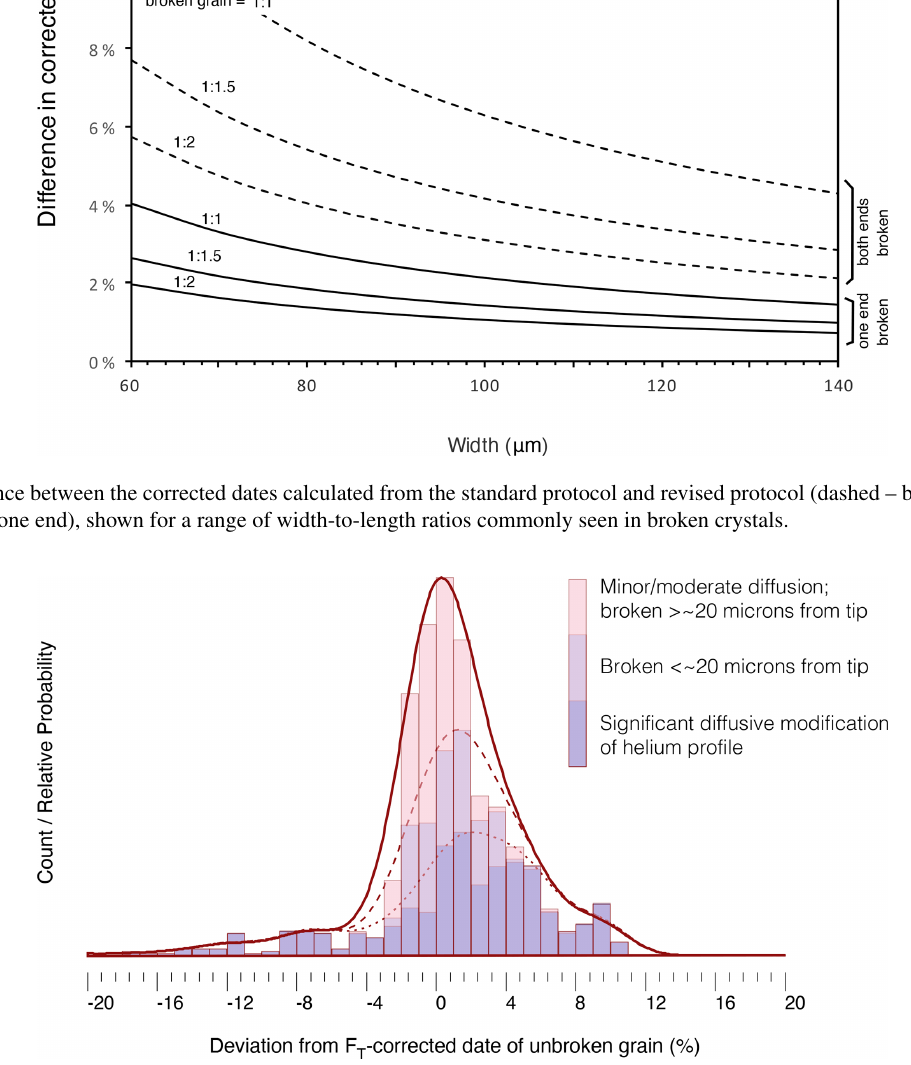
Figure 5. Uncertainty associated with the proposed fragmentation correction due to inclusion of fragments broken too close to the tip (dashed) and due to thermal histories that involve significant diffusive modification of the helium profile (dotted). The histogram and curves are stacked and cumulative, such that the dashed probability curve includes both close-to-tip fragments as well as fragments with significant diffusive